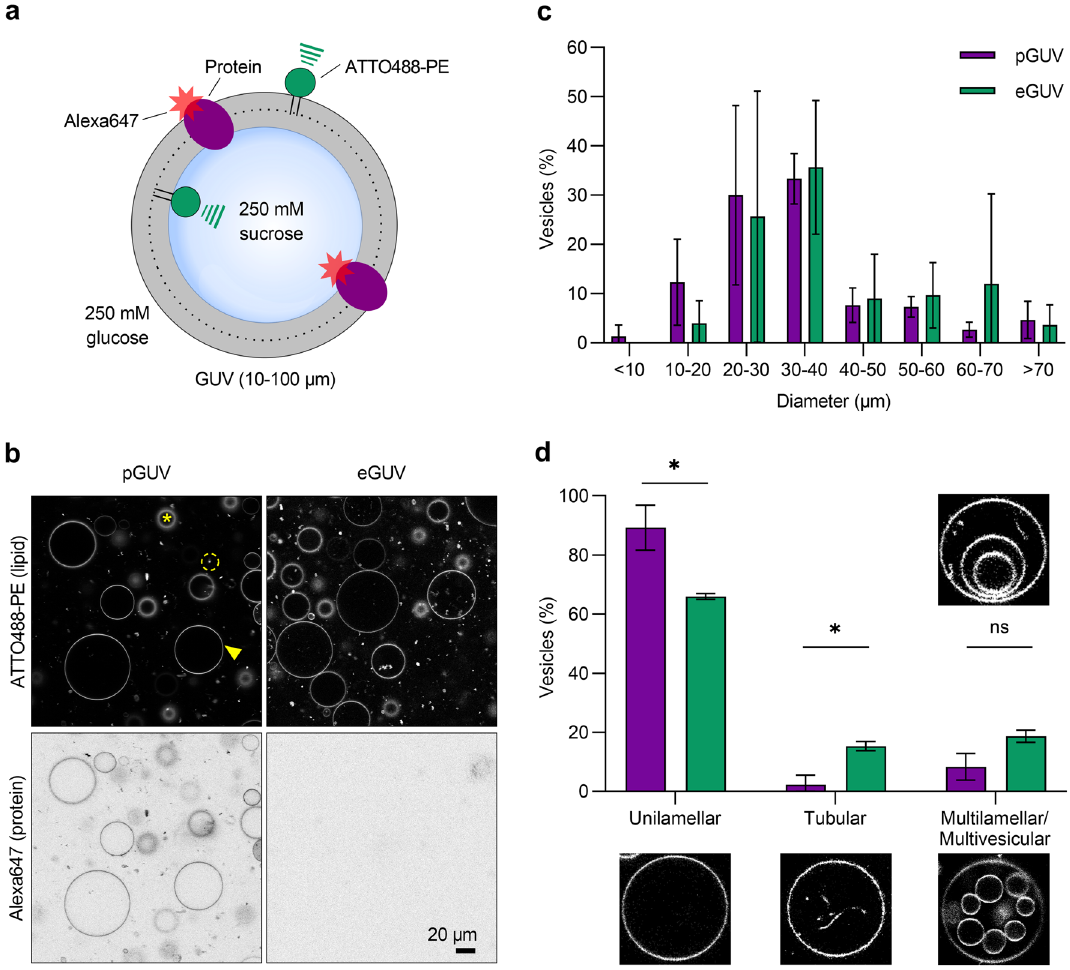
Figure 3. Characteristics of GUVs. ( a ) Protein-containing GUVs (pGUVs) and empty GUVs (eGUVs) generated in 250 mM sucrose solution were diluted in 250 mM glucose solution for observation. ( b ) Confocal images of pGUVs and eGUVs showing fluorescence channels corresponding to ATTO488-PE and Alexa647- labeled ER proteins. The arrowhead indicates an exemplary GUV used for analysis. The asterix indicates an out-of-focus GUV and the dashed circle indicates a free floating proteoliposome. ( c, d ) Size and morphology distribution of pGUVs (purple, n = 342) and eGUVs (green, n = 340). Data are presented as mean ± s.d. of three technical replicates (two-way ANOVA with Šídák’s multiple-comparisons test, * P <